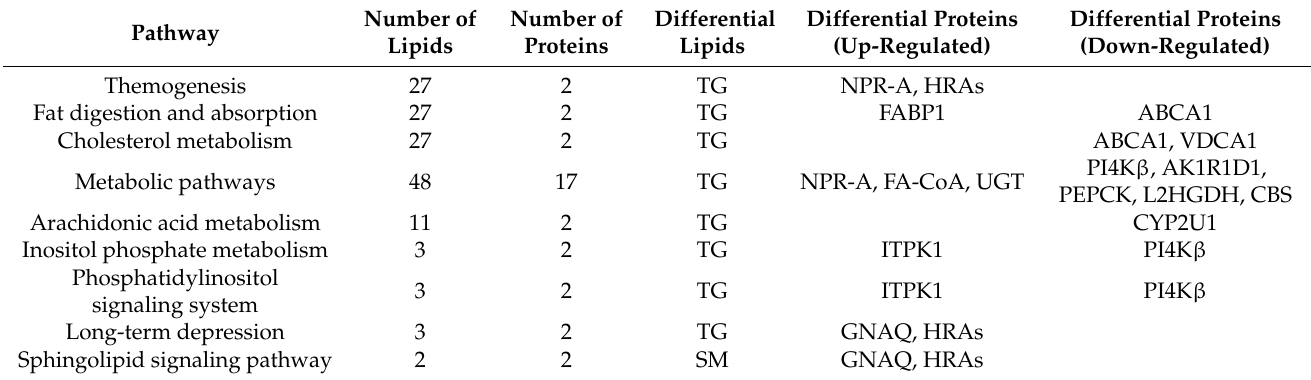
Table 11. Nine KEGG enrichment pathways of lipidomics and